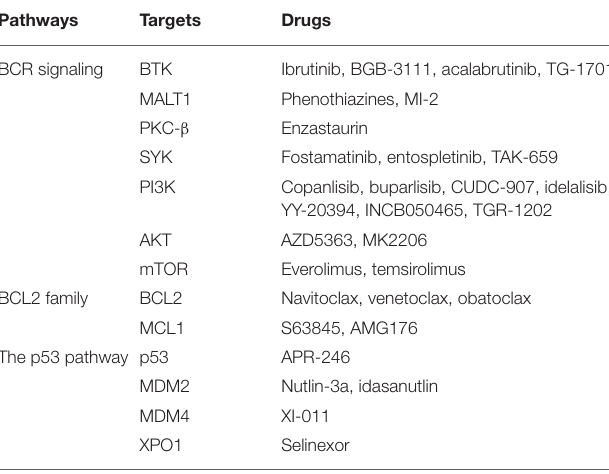
TABLE 1 | Selected drugs targeting aberrant cell survival in diffuse B cell